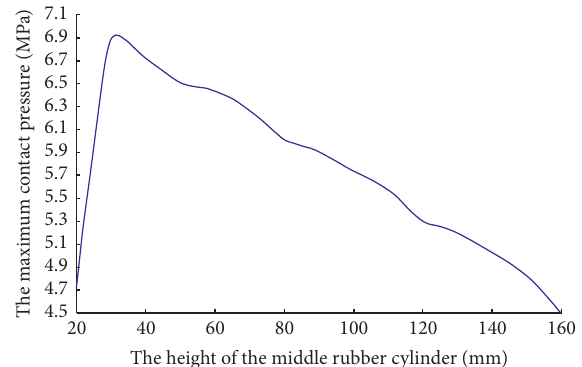
Figure 16: The relationship between the maximum contact stress and the height of the rubber cylinder.